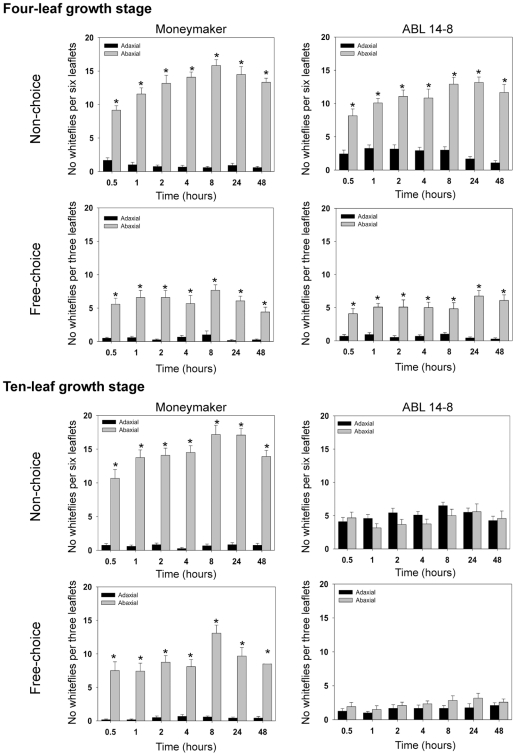
Whiteflies settling on the adaxial and abaxial leaflet surfaces of ‘Moneymarker’ and ABL 14-8.Free-choice and non-choice preference assays of B. tabaci on the adaxial and abaxial leaflet surfaces of‘Moneymaker’ and ABL 14-8 nearly-isogenic tomato lines at four and ten-leaf growth stage. Mean number of whiteflies per six leaflets under non-choice conditions and mean number of whiteflies per three leaflets under free-choice conditions on the adaxial (black bars) and abaxial (grey bars) leaflet surfaces of ‘Moneymaker’ and ABL 14-8 at different time intervals after release of 30 whiteflies per test in the centre of the arena. Asterisks indicate significant differences (P<0.05) between both the abaxial and the adaxial leaf surfaces at each time interval using Mann-Whitney U-test. Bars indicate the standard error of the mean.